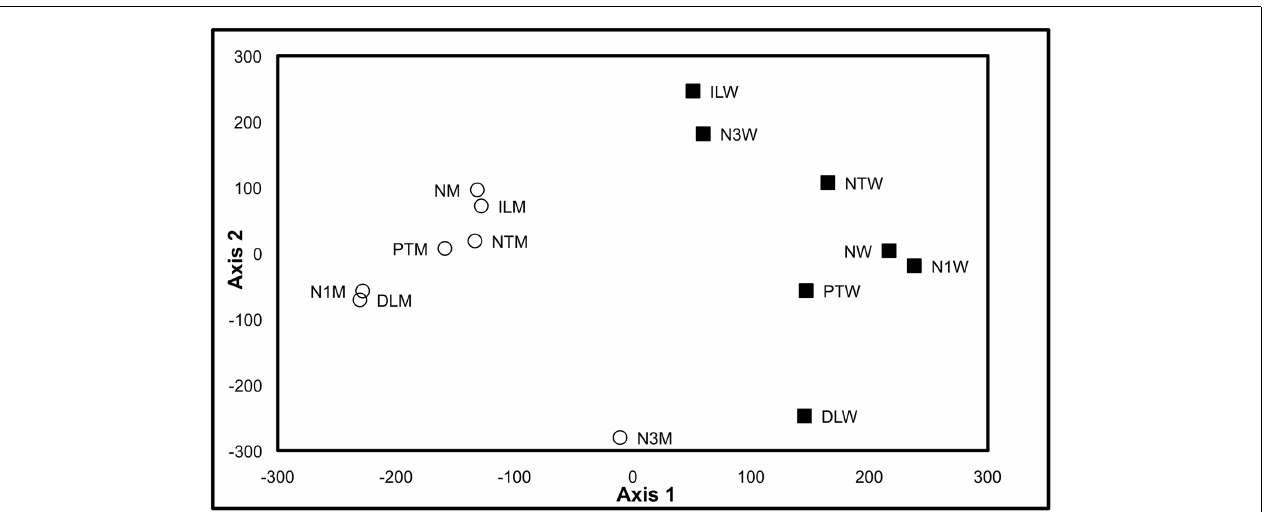
FIGURE 2 | Multi-dimensional scaling plot of Environmental Impact Experiment. Multi-dimensional scaling plot of the data generated in the Environmental Impact Experiment reveals a clear separation of wild-type samples (filled squares) from the mutant samples (open circles). Standard “normal” growth conditions for the wild-type and At1g52670 (SALK_021108) mutant allele are denoted as NW and NM, respectively. Similarly environmental perturbations (described in Table 2 ) labeled on MDS plot for wild-type and mutant samples are as follows: positive